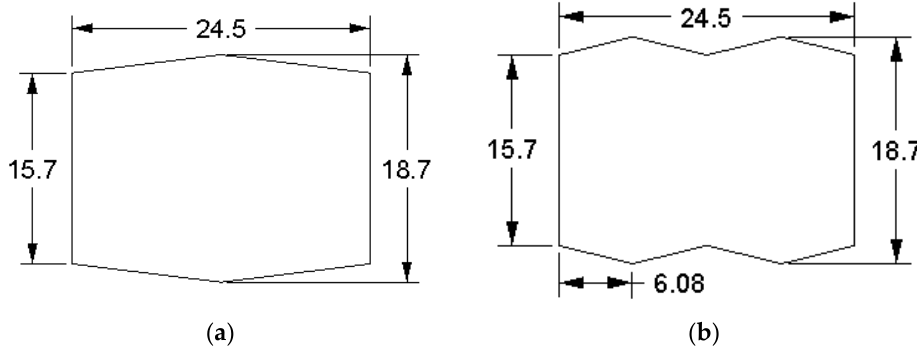
Figure 7. Roller front and side views with geometric dimensions. All dimensions are in mm.